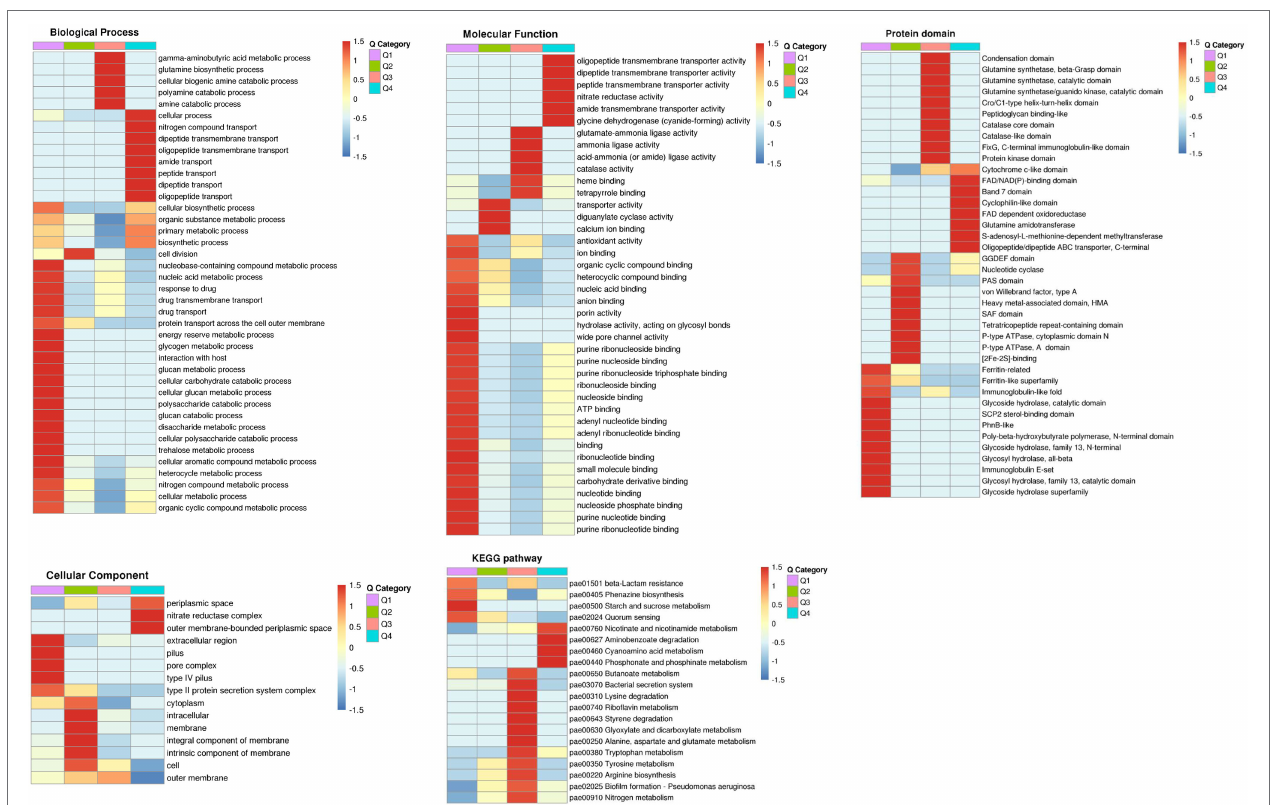
FIGURE 8 | Heat maps showing the enrichment for GO (biological process, molecular function, and cellular component), the KEGG pathway, and protein domain of differentially expressed protein groups, divided based on their differential expression ratios. Red color indicates significant enrichment and blue color indicates insignificant enrichment.